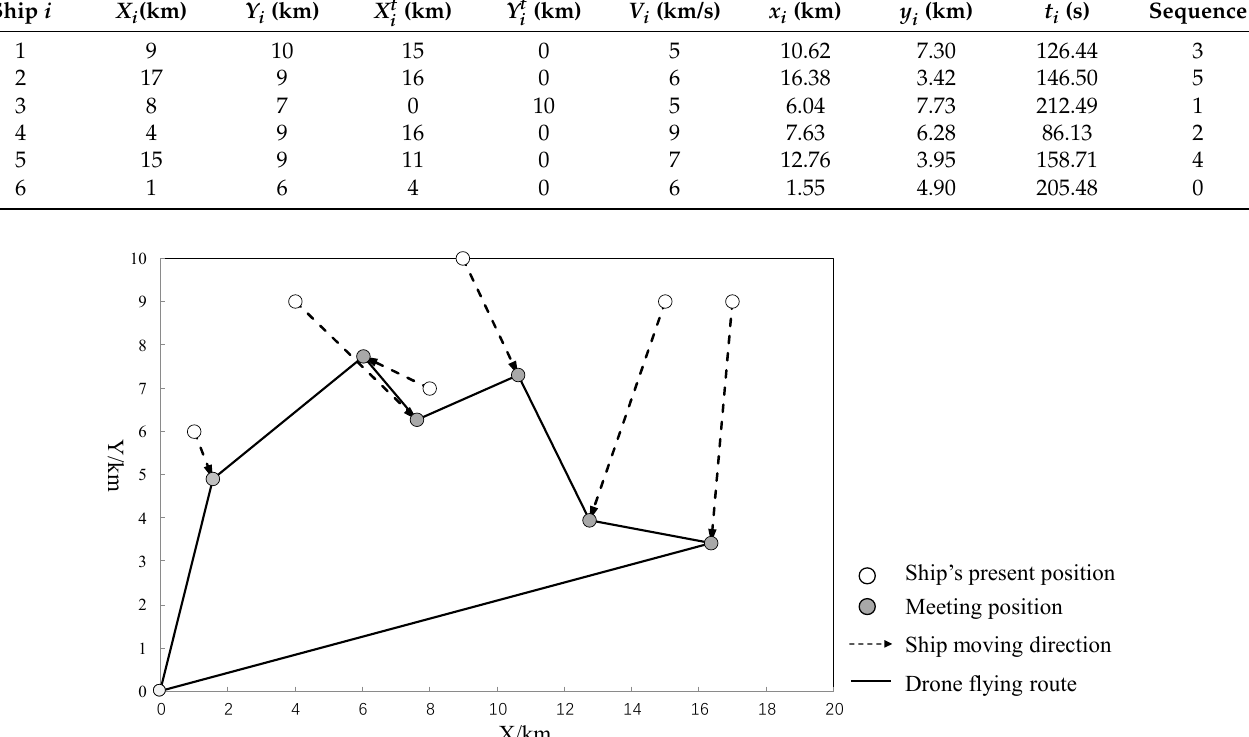
Figure 11. Influence of crossover rate and mutation rate on genetic algorithm.